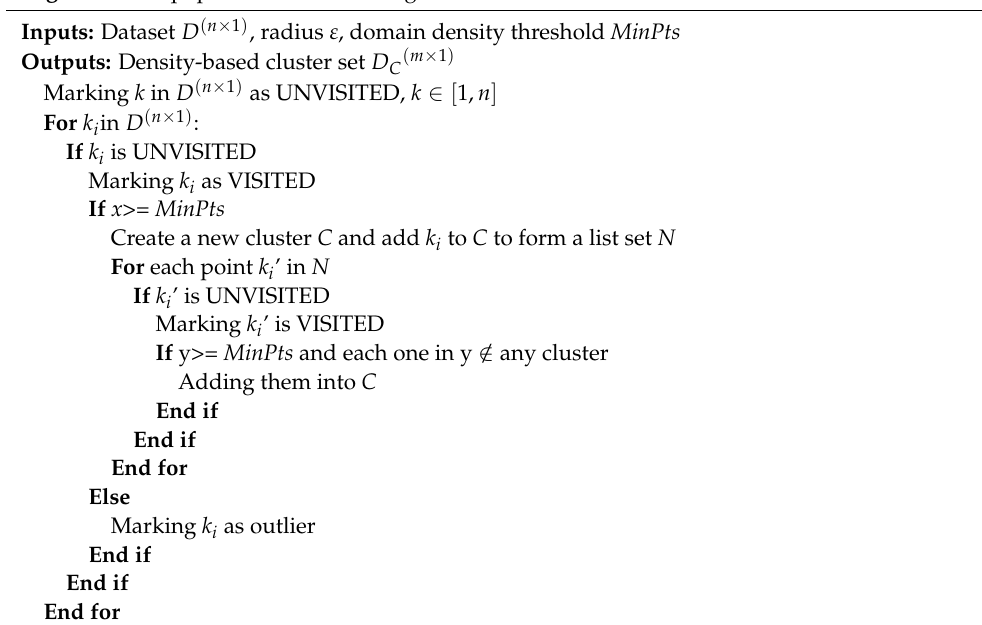
Algorithm 1 Equipment outlier